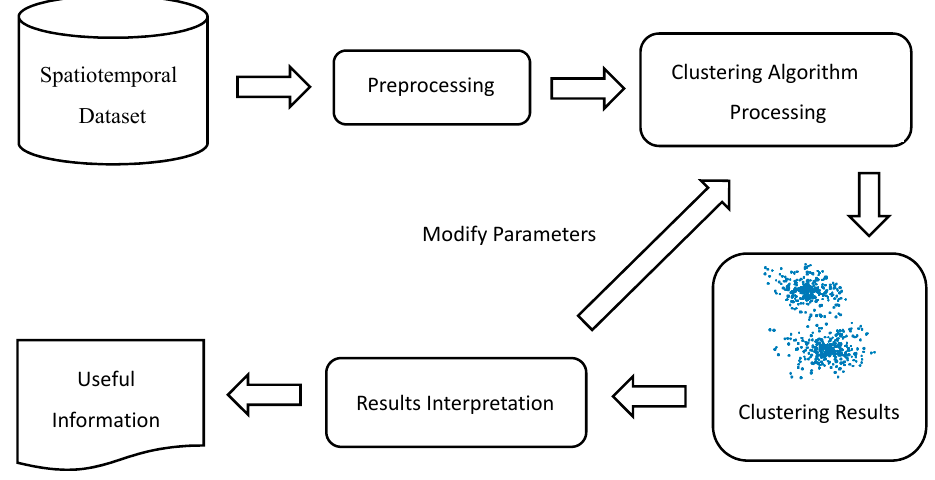
Figure 2. Procedure of clustering.